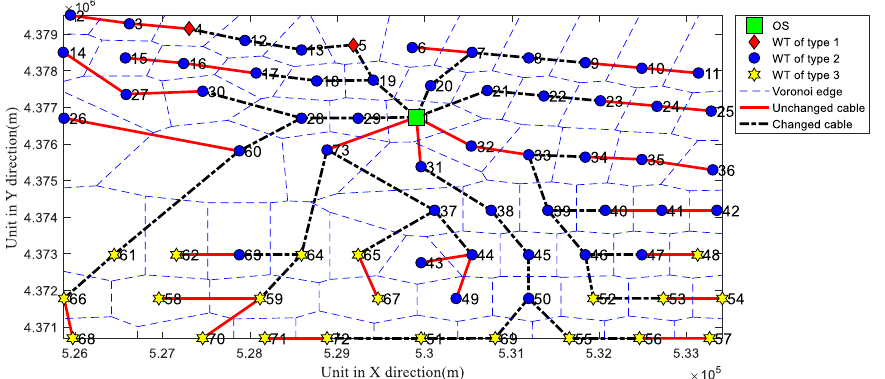
Figure 10. Optimized layout of Model 2 and highlighted the cables which changed the cross-section.